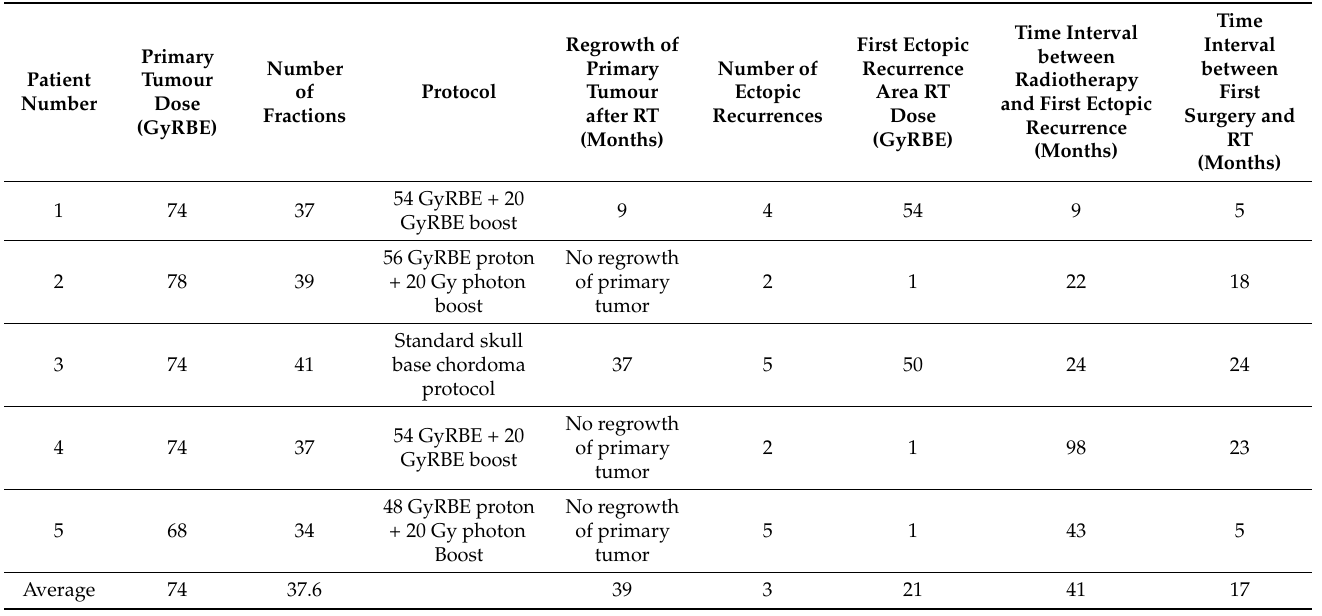
Table 2. Radiotherapy data and timing of radiotherapy compared to surgery and development of ectopic recurrence. The first recurrence area radiotherapy dose is the dose that was delivered to the area where the first diagnosed recurrence appeared. RT = radiotherapy. GyRBE = Gray